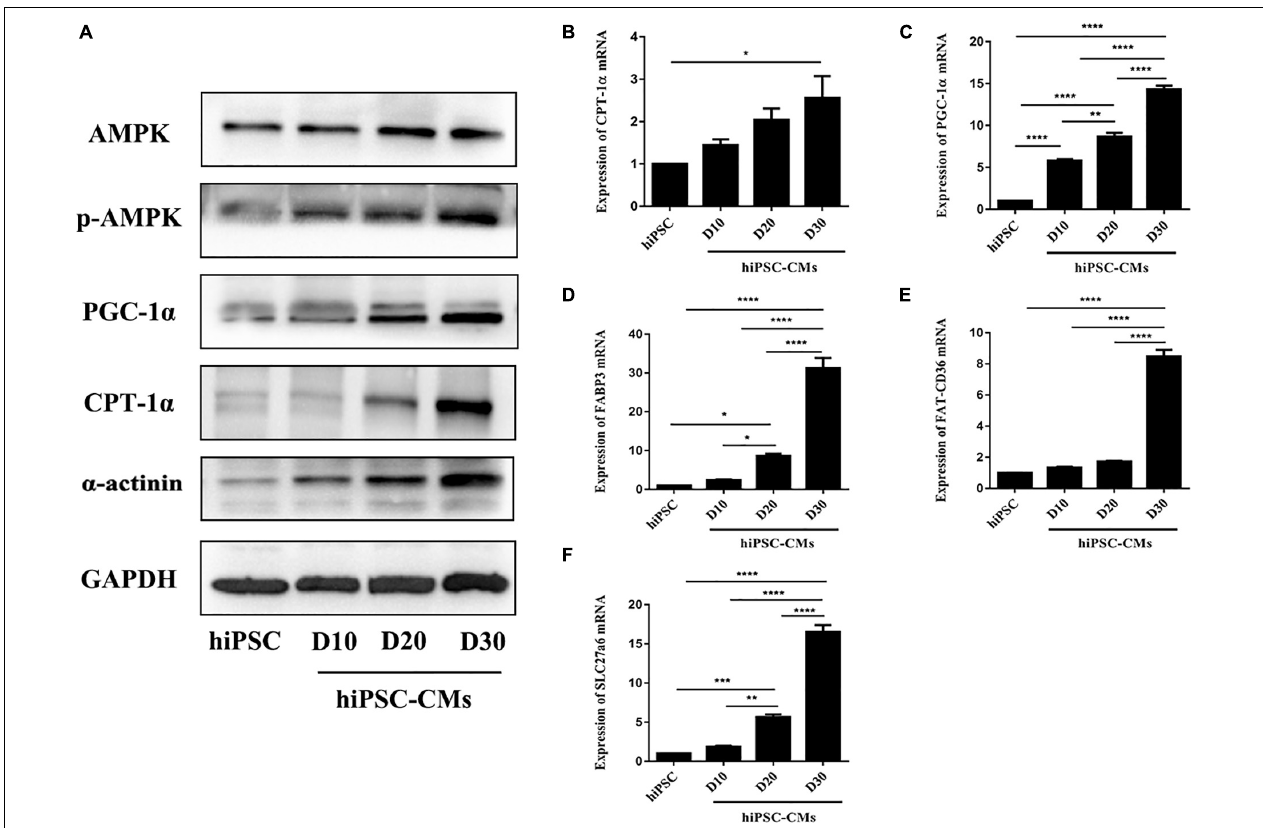
FIGURE 2 | Activation of AMPK during hiPSC-derived cardiomyocyte differentiation. (A) Western blot analysis of AMPK, phospho-AMPK, PGC-1 α , CPT-1 α , and α -actinin on days 0, 10, 20, and 30 during hiPSC-derived cardiomyocyte differentiation. RT-qPCR analysis of the genes regulating energy metabolism [PGC-1 α (B) and CPT-1 α (C) ] and fatty acid transport and oxidation-related genes [FABP3 (D) , FAT-CD36 (E), and SLC27a6 (F) ] in hiPSC-derived cardiomyocytes on days 0, 10, 20, and 30 ( n = 3). * P < 0.05, ** P < 0.01, *** P < 0.001, **** P < 0.0001 one-way